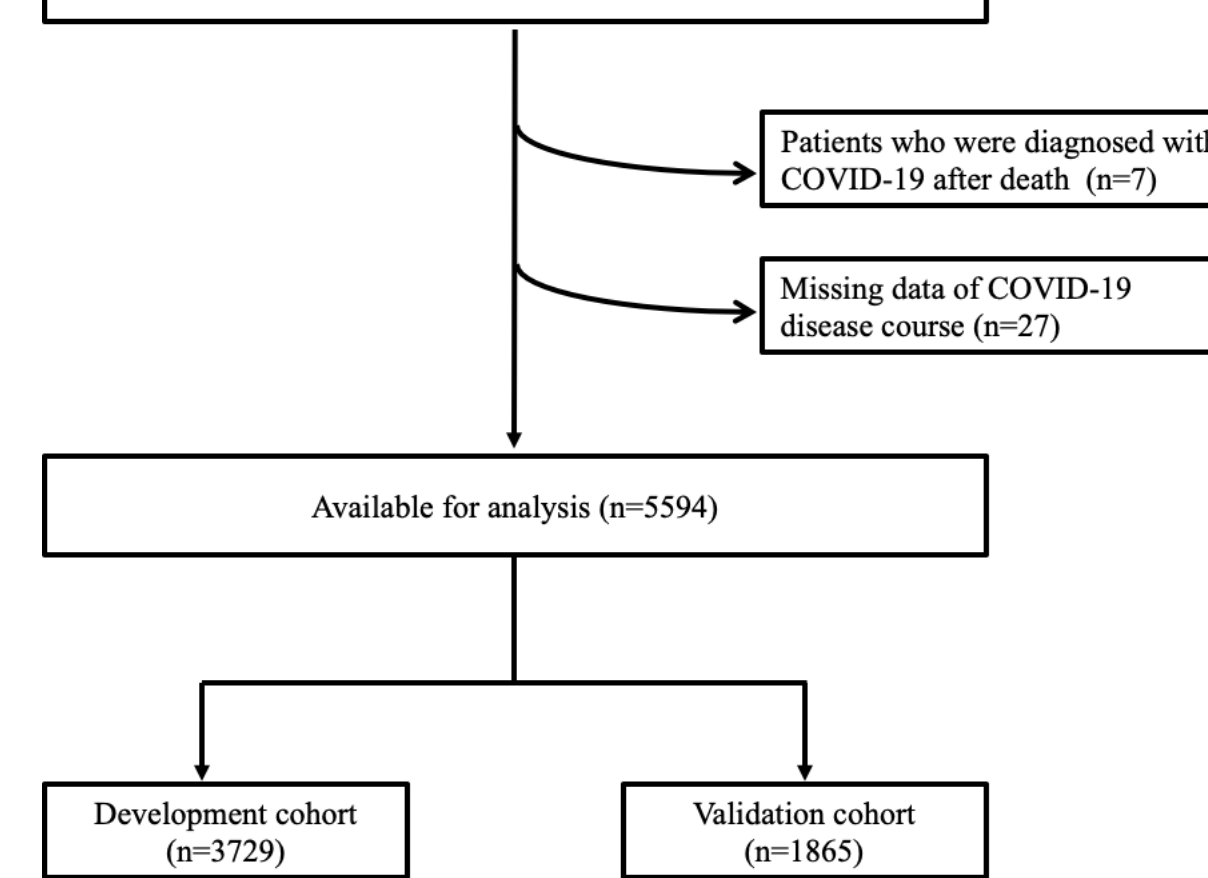
Figure 1. Flow diagram of the nationwide cohort of patients with